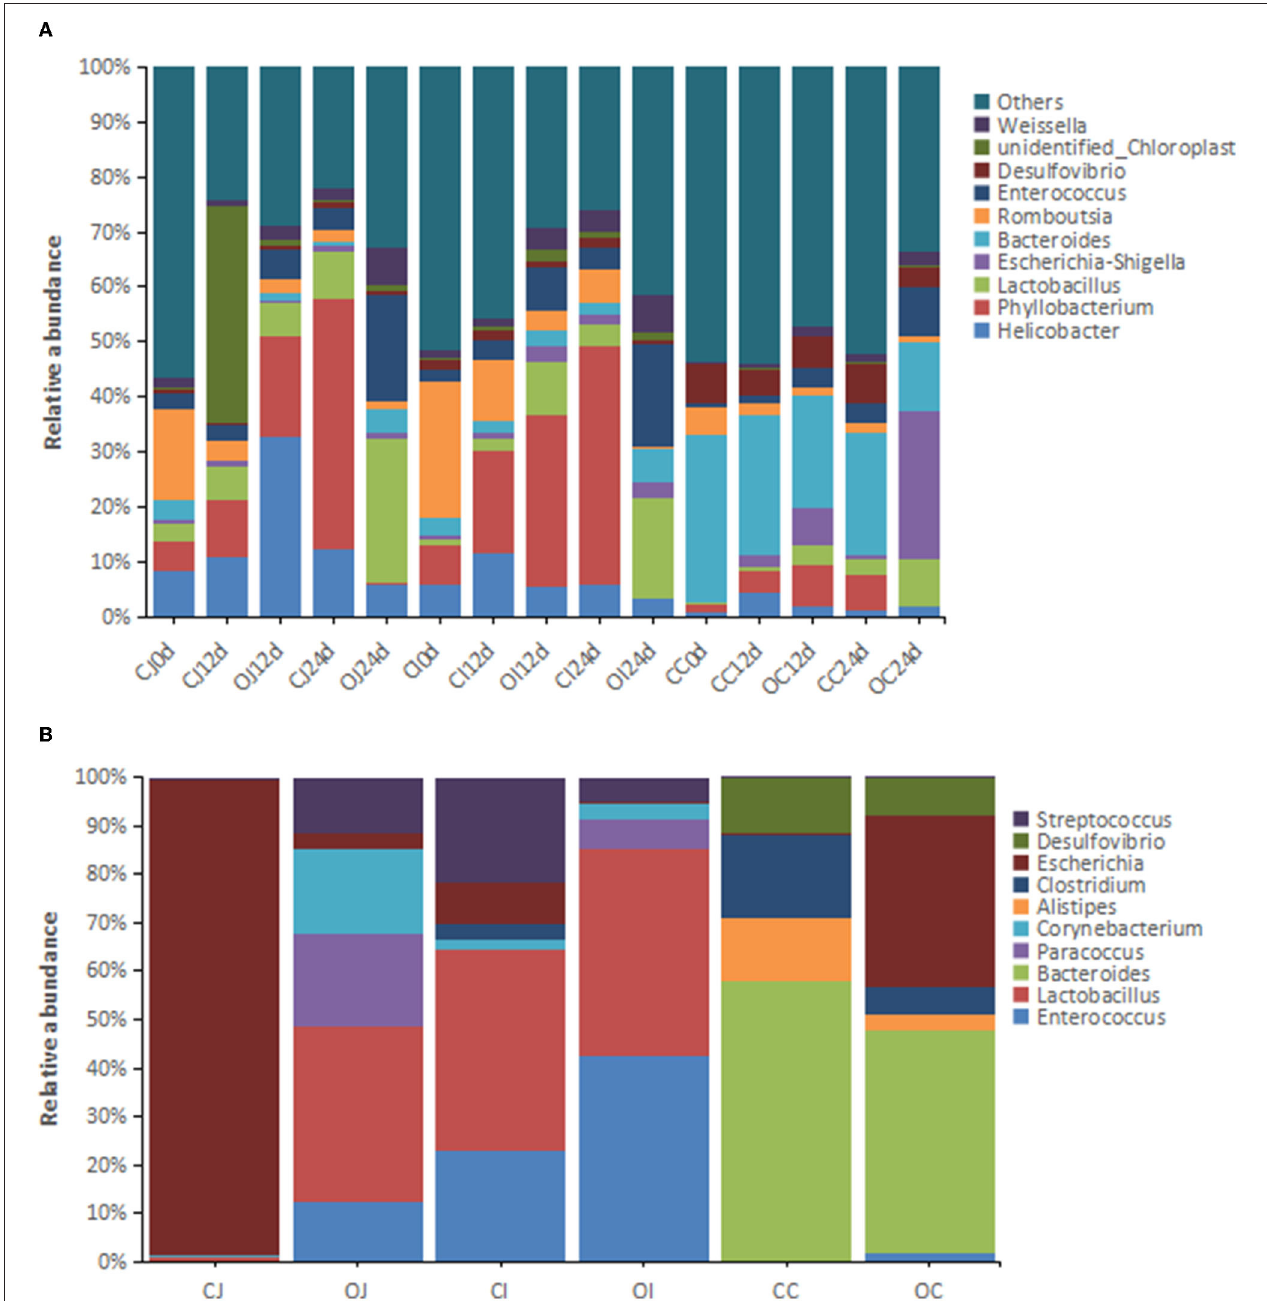
FIGURE 2 | The histograms showing the relative abundance of the top 10 genera in different intestinal tracts revealed by (A) 16S rRNA analysis ( n = 16) and (B) metagenomic analysis ( n = 4). Note: “CJ” and “OJ” denote the jejunal tracts of the control group and the overfeeding group, respectively. “CI” and “OI” denote the ileal tracts of the control group and the overfeeding group, respectively. “CC” and “OC” denote the cecal tracts of the control group and the overfeeding group, respectively.